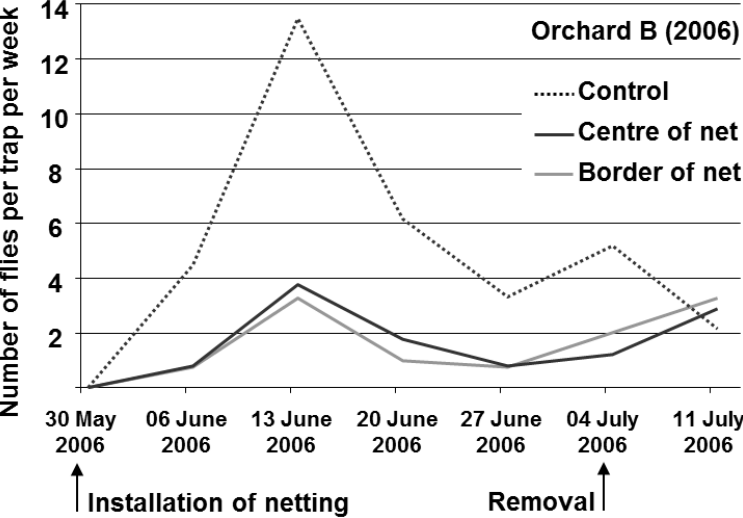
Figure 2. Flight activity of R. cerasi in orchard B in